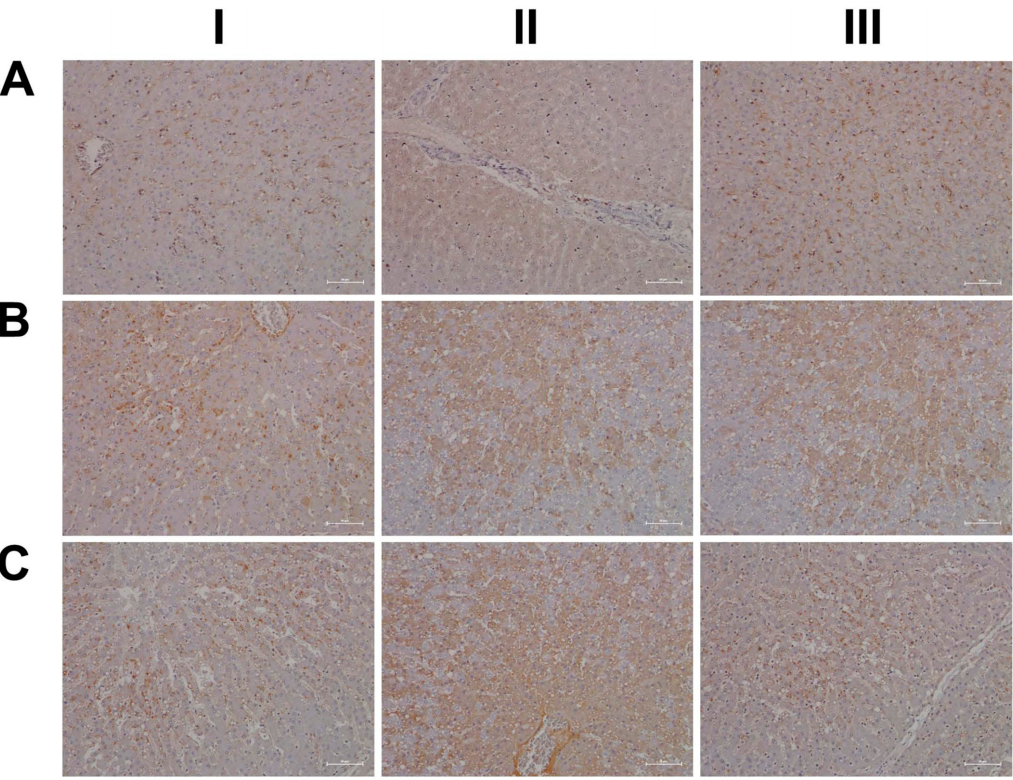
Figure 18. Immunohistochemistry of the corticotropin-releasing hormone receptor in liver sections of control and diclofenac-treated animals after daily dosing for 28 days. For its important role